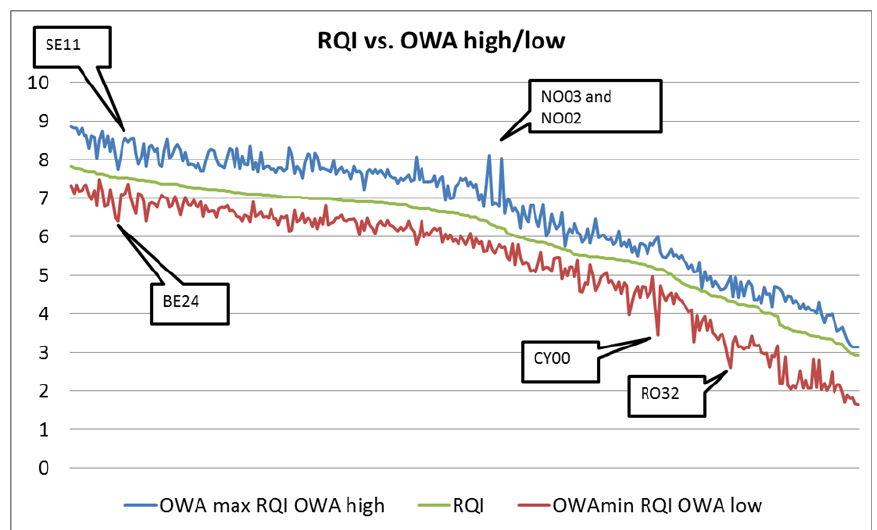
Figure 2: Analysis of compensability effects by determination of Regional Quality of Living applying the equal weighting method and the Ordered weighted Averaging method